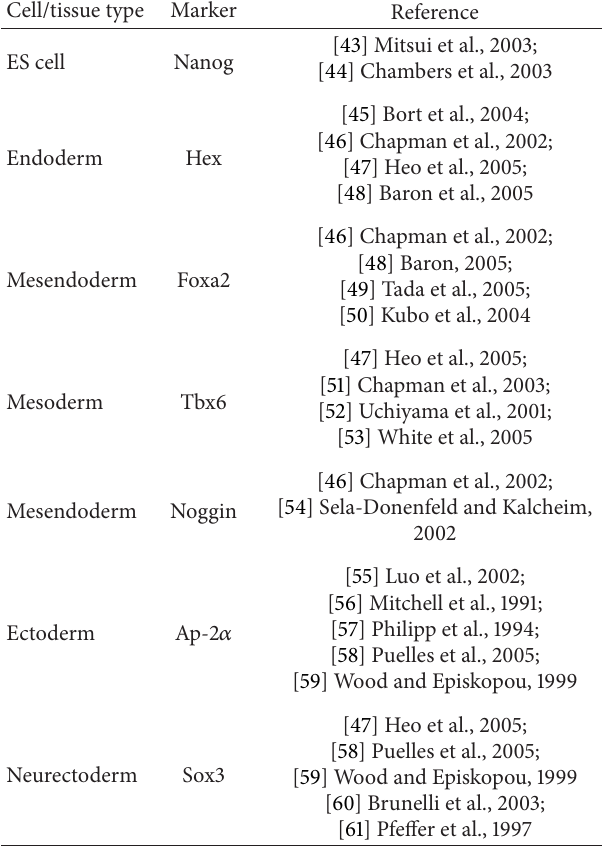
Table 1: Tissue specific markers.